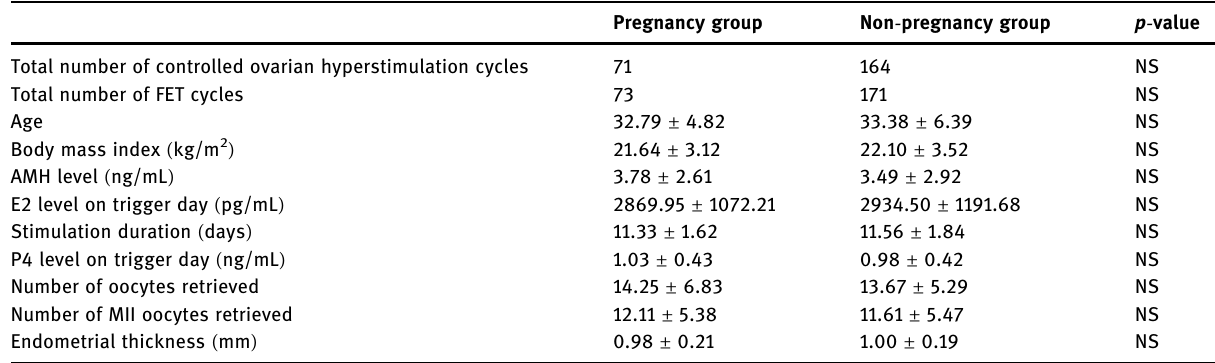
Table 1: Demographic